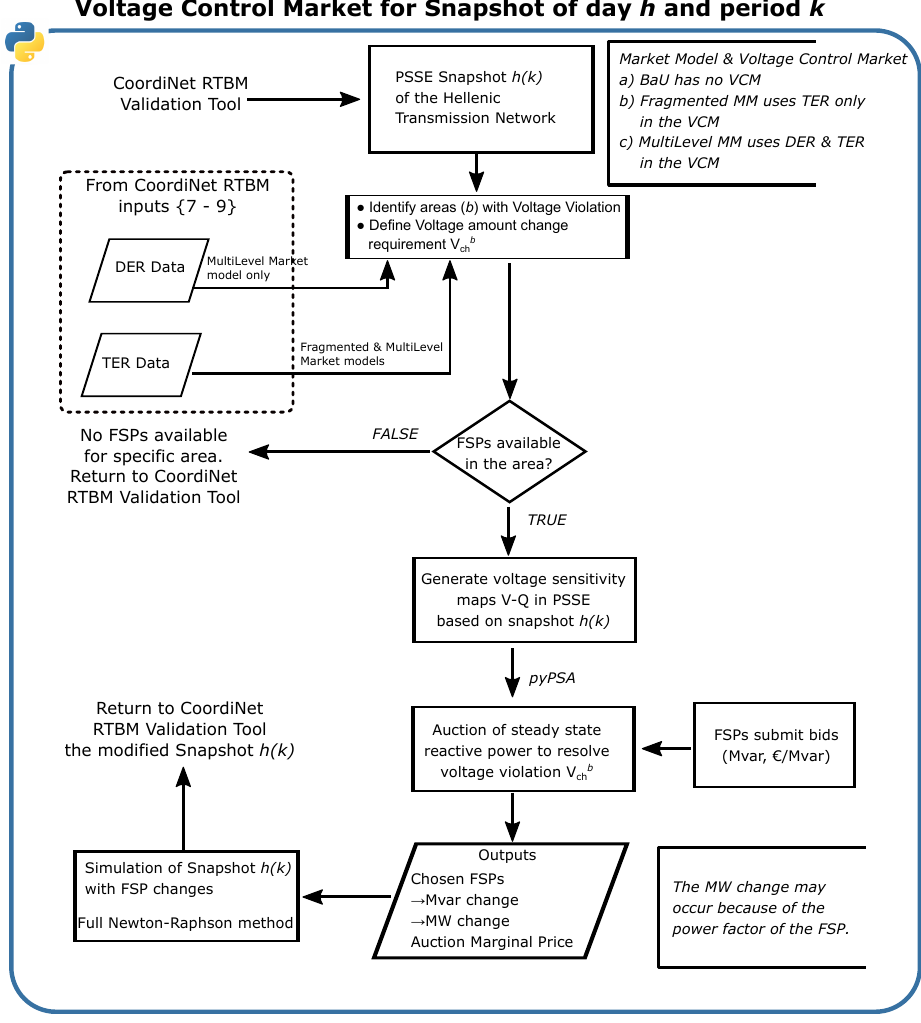
Figure 3. Architecture of the Voltage Control